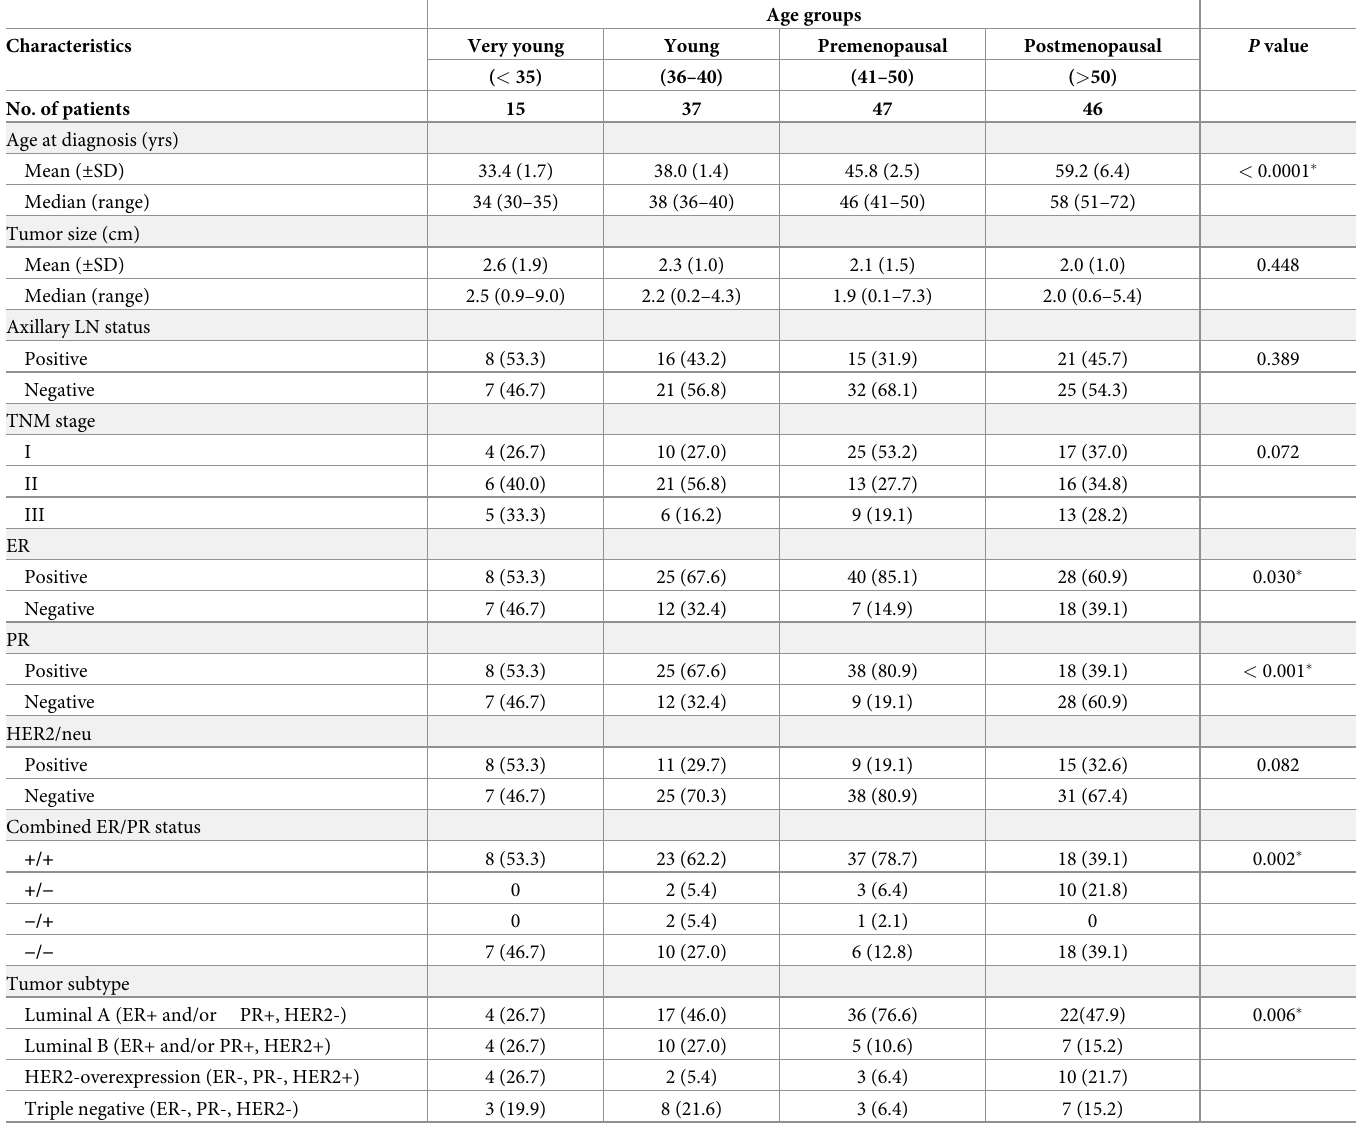
Table 3. Clinicopathological characteristics of enrolled patients divided among four age